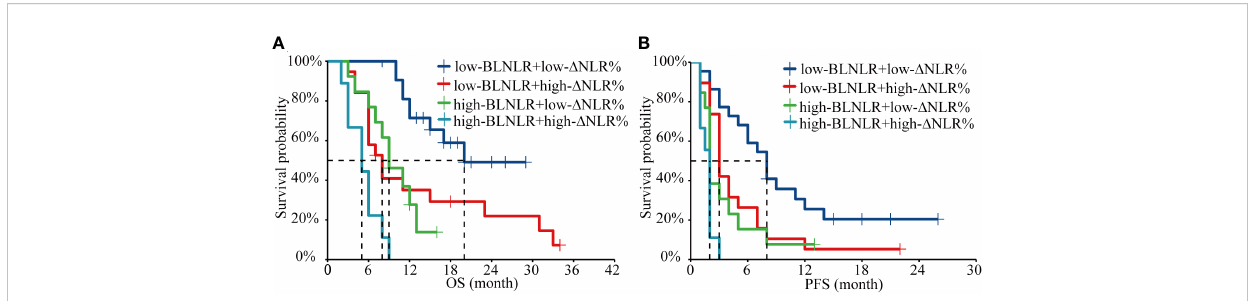
FIGURE 2 Kaplan-Meier analysis of OS and PFS for the combination of BLNLR and D NLR%. (A) OS curve. (B) PFS curve. BLNLR, neutrophil-to-lymphocyte ratio before the fi rst cycle of PD-1 inhibitor; D NLR%, relative NLR change (calculated as % change) before the third cycle of PD-1 inhibitor; BMI, body mass index; OS, overall survival; PFS, progression-free